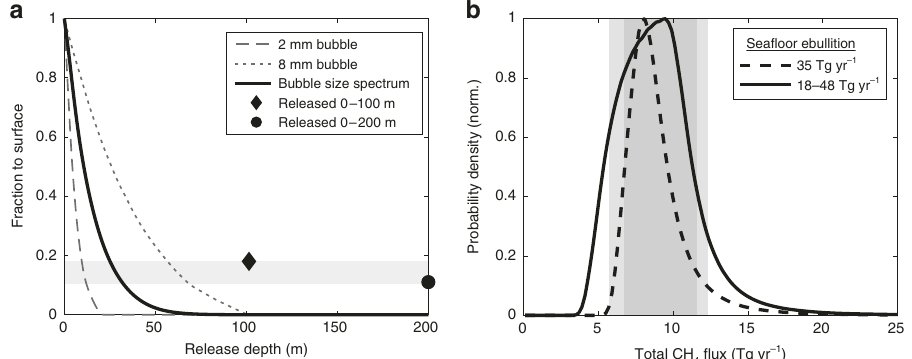
Fig. 5 Ebullitive and total CH 4 emissions. a Modeled transfer ef fi ciency of CH 4 in bubbles from the sea fl oor to surface ocean, for 2 and 8 mm diameter bubbles, and integrated across a characteristic bubble size spectrum (Supplementary Fig. 7). Diamond and circle points represent the mean transfer ef fi ciency for bubbles released uniformly between 0 – 100 and 0 – 200 m, respectively, and gray shading marks the range of 11 – 17% bounded by these cases. b Probability density functions for total oceanic CH 4 emissions, combining the distribution for diffusive fl uxes (Fig. 4b) with two uniform probability distributions for ebullitive emissions that are obtained by applying 11 – 17% transfer ef fi ciency to sea fl oor ebullition rates of 35 and 18 – 48 Tg yr − 1 . Dark and light gray shading mark the likely range (10 – 90th percentiles) for the two estimates